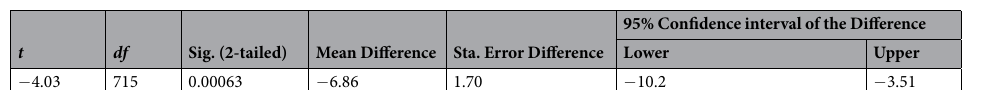
Table 1. Variations in T-test results for independent samples of the three-year averaged ozone concentrations between the densely and sparsely regions. Note: t is the computed T-test statistic, df is the degrees of freedom, Sig. (2-tailed) is the p -value corresponding to the given test statistic and degrees of freedom, Mean Difference is the difference between the sample mean, Std. Error Difference is the different in the standard error.